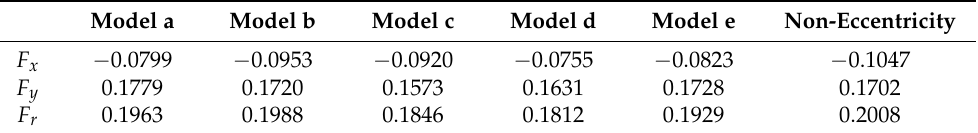
Figure 9. Time–Domain Diagram of the Radial Force on the Impeller. ( a ) Radial force component in the x-direction; ( b ) Radial force component in the y-direction; ( c ) Radial force. the x -direction; ( b ) Radial force component in the y -direction; ( c ) Radial force. Table 2. The mean time of radial force on the impeller. Table 2. The mean time of radial force on the